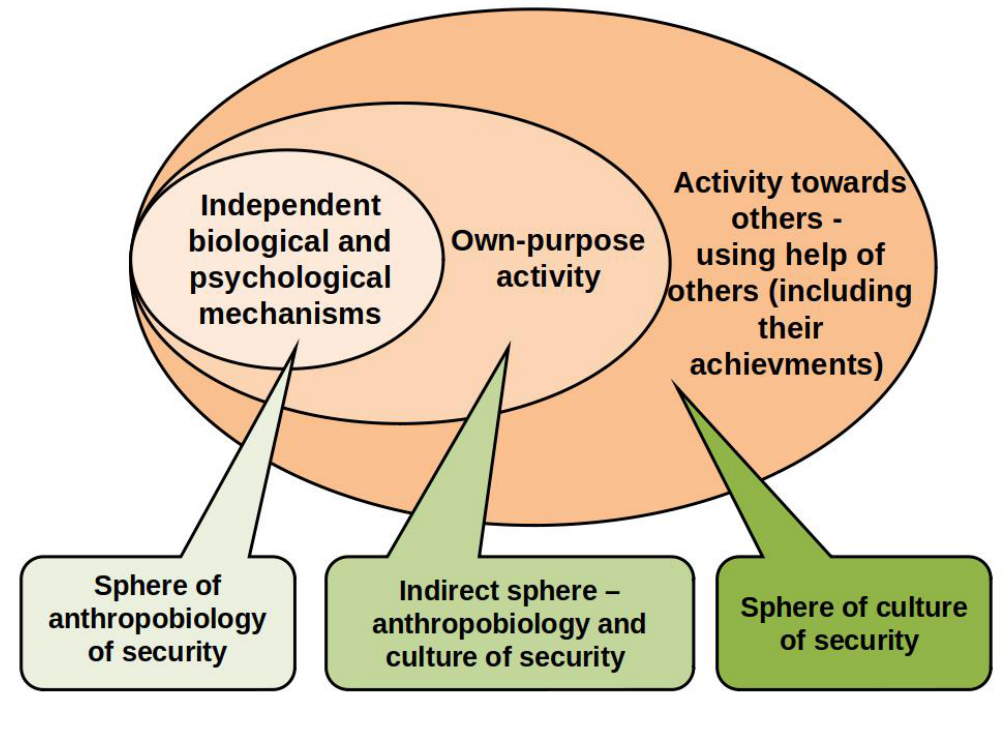
Figure 2. Human activity and security